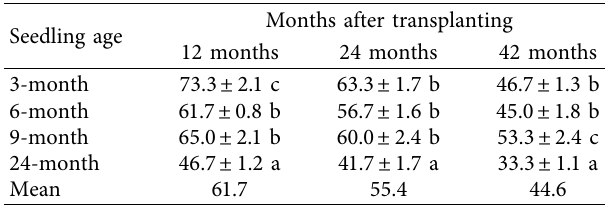
Table 2: Effect of seedling age on survival rate percentage of S. macrophylla seedlings after 12, 24, and 42 months of outplanting (mean ±